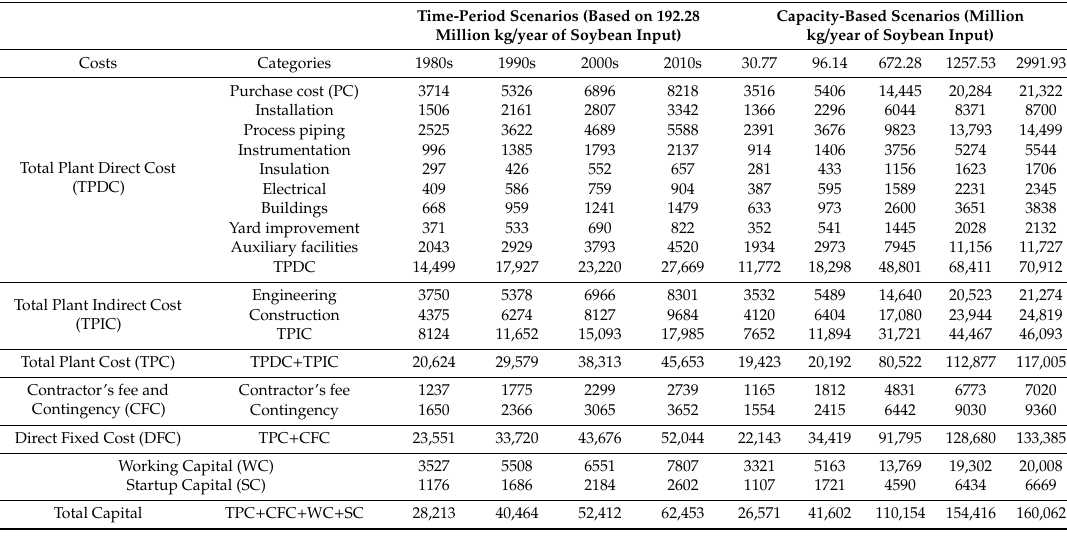
Table 6. Capital investment estimations for extruding-expelling of soybean oil ($1000, based upon 2015